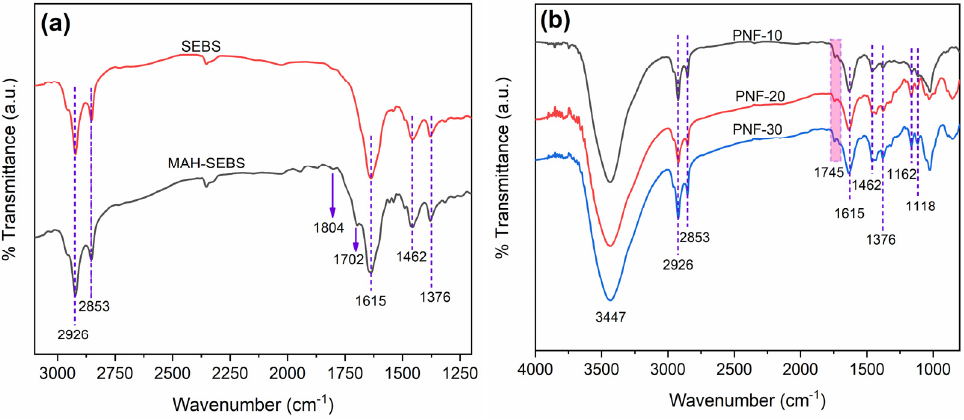
Figure 2. FTIR spectra of the ( a ) matrix, compatibilizer, and ( b ) composites.